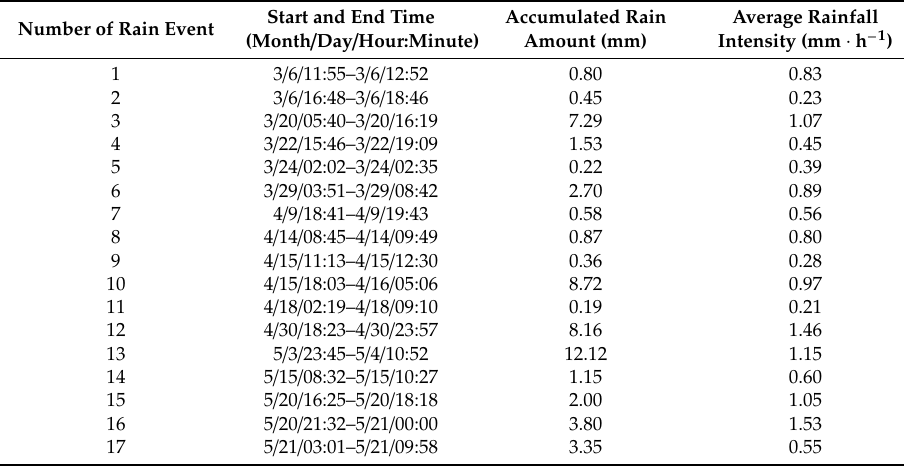
Figure 12. Schematic diagram of the diurnal variation of clouds (the green five-pointed star represents the position of the new source). Table 3. The start and end time, accumulated rain amount and average rainfall intensity of each precipitation event.